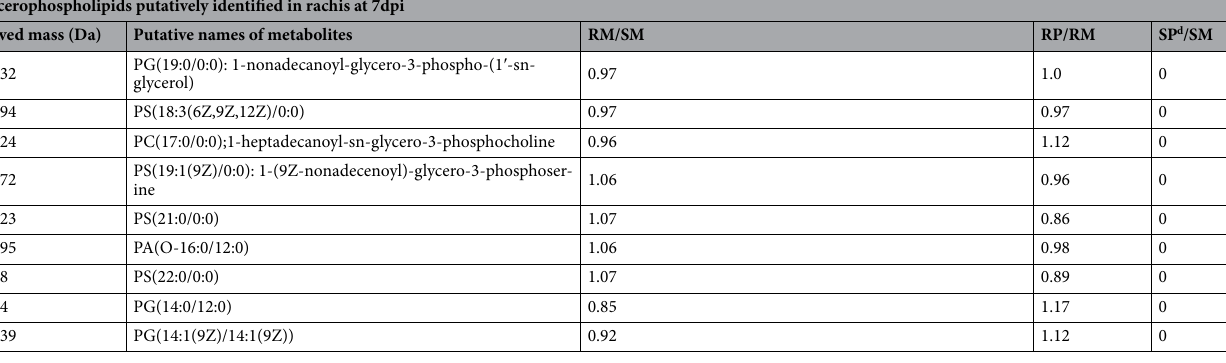
Table 1. Metabolites putatively identified, in spikelets and rachises of wheat NILs with resistant and susceptible QTL-Fhb1 alleles, at 3 ( a ) and 7 ( b ) days post-inoculation with F. graminearum, respectively (details in Supplementary Table S2). a The metabolite mass was included only when the observed mass accurate mass error, AME was < 5 ppm, which was calculated as [(Observed mass − Exact mass)/Exact mass] × 10 6 . To the observed mass one 1H was added, where the mass of H = 1.007276, as the mass was detected based on the negative ionization mode, using LC-HRMS. b Fold change in abundances of induced resistance (IR) metabolites in NIL-R, calculated as the abundance: IR = (RP/RM)/(SP/SM), where R is resistant NIL, S is susceptible NIL, M is mock inoculated, and P is pathogen inoculated. c Significance calculated based on student t-test P value: *** < 0.001, ** < 0.01, * < 0.05, NS is Not-significant. d In (b), SP/SM = 0, because these metabolites were absent in the SP, at